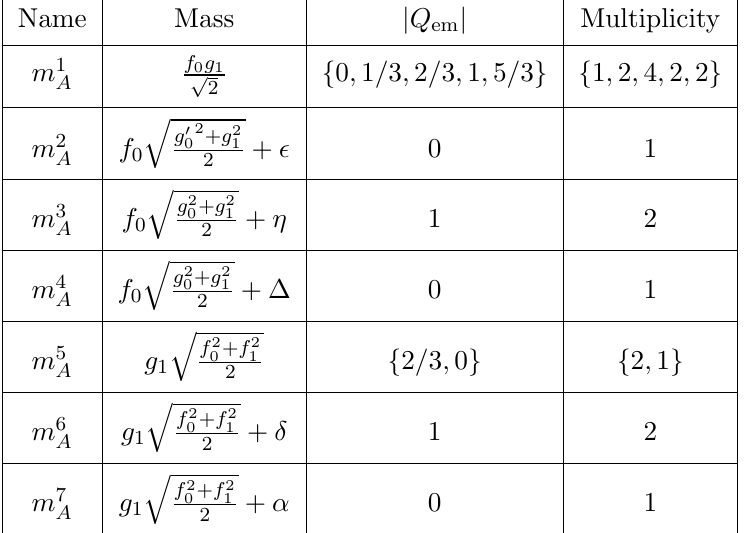
Table 2 . Spectrum of vector boson resonances with their masses and electric charges. m i a generic denomination for all the vector resonances with the same mass. In cases with several charges, the multiplicities follow the order of the charges. (cid:15) , (cid:17) , (cid:1), (cid:14) and (cid:11) stand for corrections to the masses due to EWSB that can not be computed analytically (although it is possible to obtain simple expressions expanding in powers of (cid:24) ).